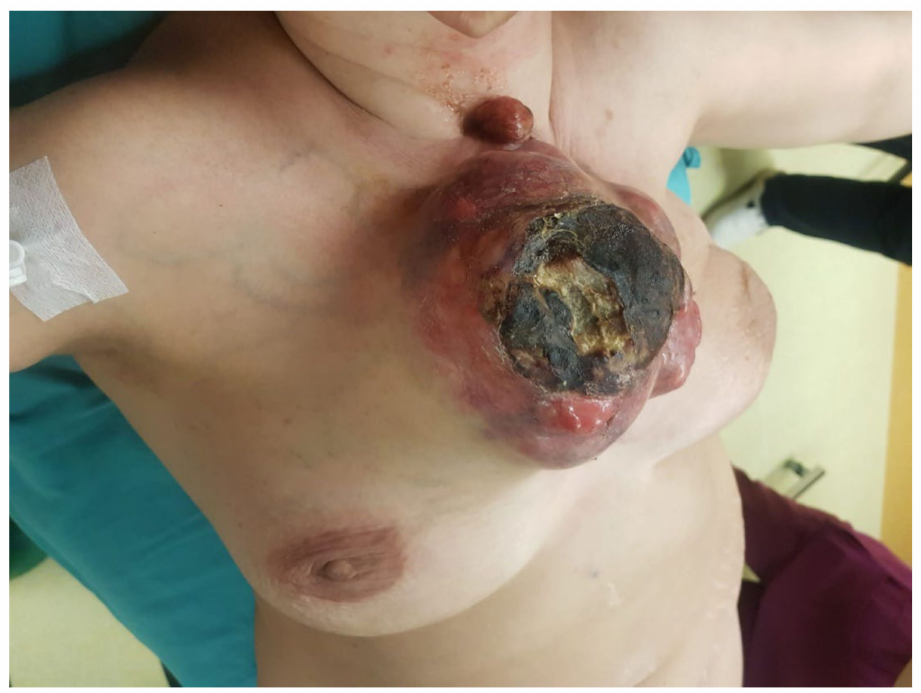
Figure 9. Preoperative aspect of the